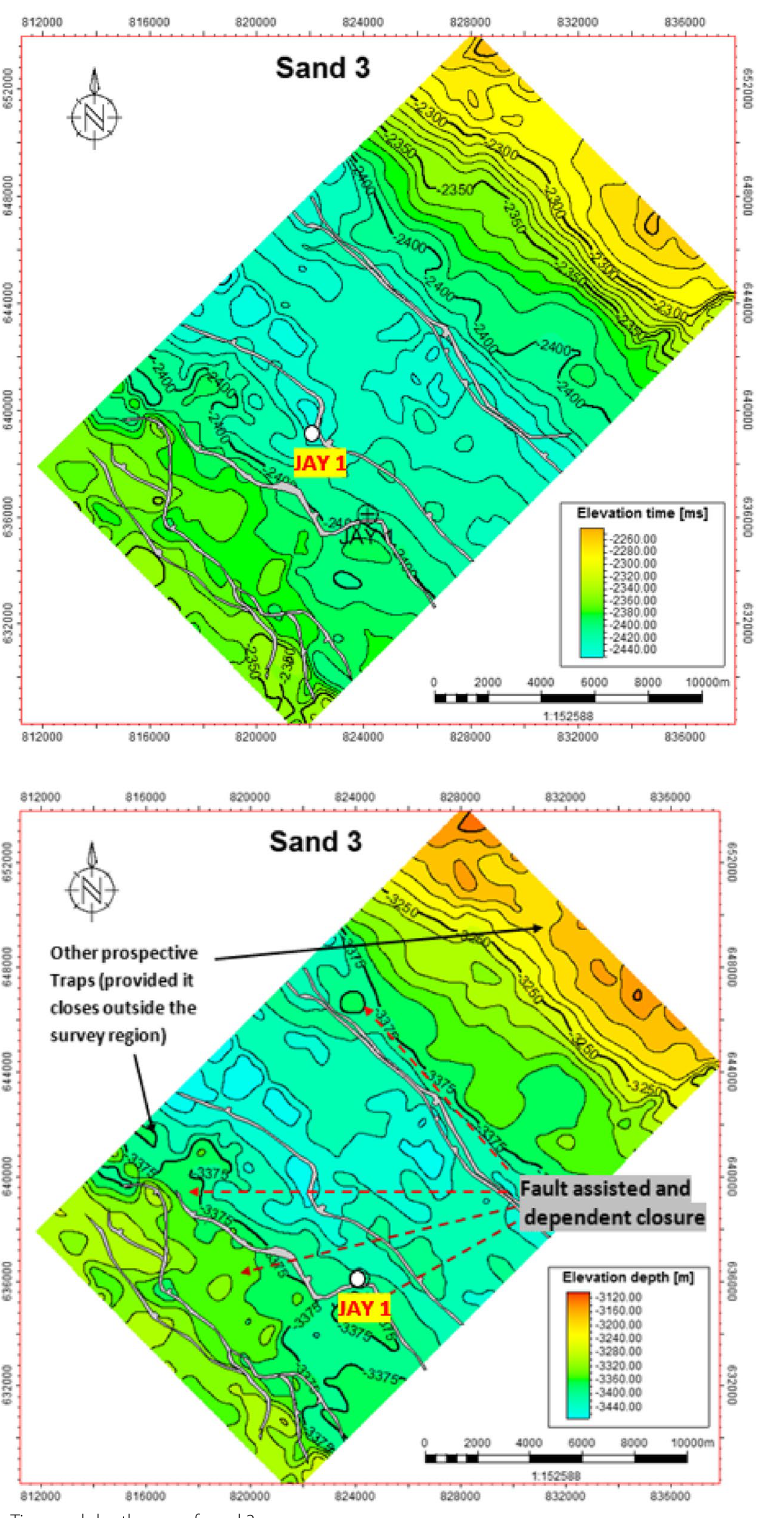
Fig. 15 Time and depth map of sand